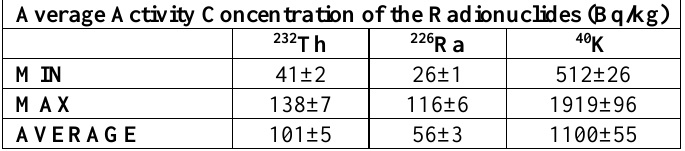
Table 1: Activity Concentration of the Collected Samples.